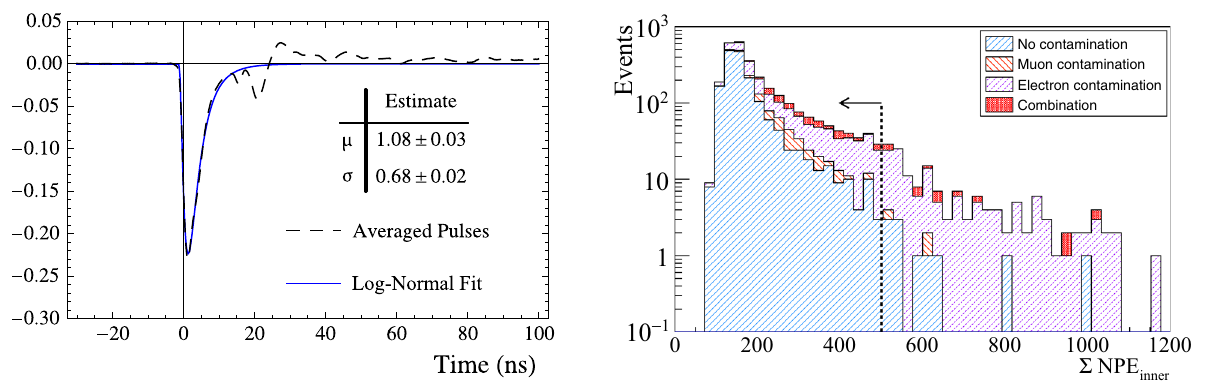
Fig. 3 Monte Carlo simulation of the summed PE distribution on the inner PMT group due to cosmic muon events with perfect rings (turquoise, right diagonal hatching), muon contamination (orange, left diagonal hatching), electron contamination (purple, right diago- nal dashed hatching), and the total (red, solid) for an LAB/PPO target. The vertical black dashed line represents the chosen cut value, with the arrow to illustrate the acceptance region. Taken from